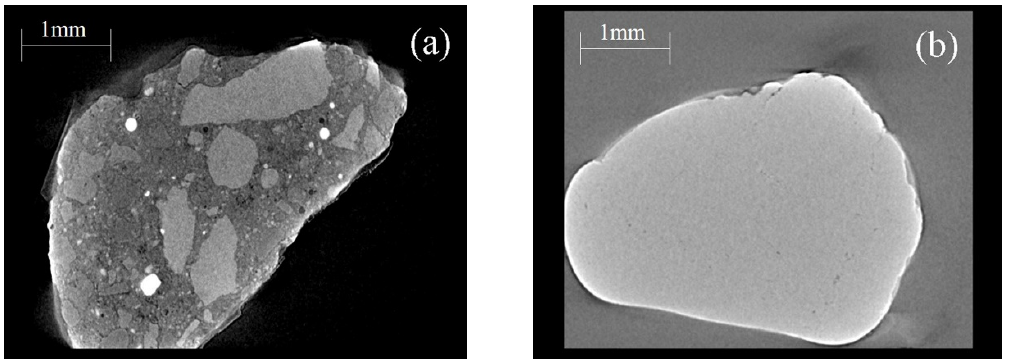
Figure 7. Computed tomography (CT) images of fine aggregate: ( a ) RFA and ( b ) NFA.